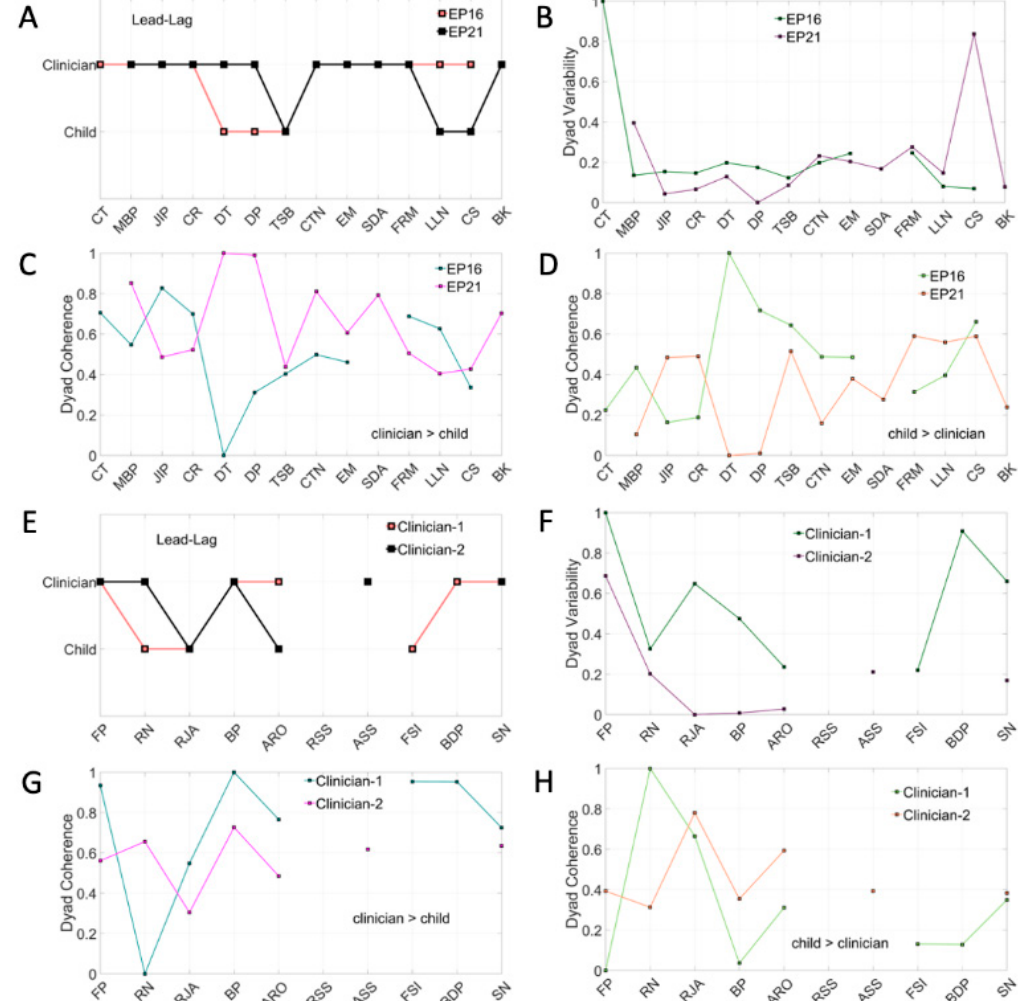
Figure 7. Vignettes samples show bottlenecks of pencil and paper observation methods. ( A – D ) Macro-level scoring system does not capture change in developmental socio-motor physiology. Experimental participants EP16 and EP21 are perceived very di ff erent by the same clinician in relation to leading patterns ( A ); Dyad Variability ( B ) and Dyad Coherence ( C , D ) in each of the clinician → child and child → clinician directions. ( E – H ) Ill-posed autism detection problem: Given the ADOS score, what is the most likely socio-motor phenotype? Each clinician perceives the same child di ff erently across all micro-level socio-motor